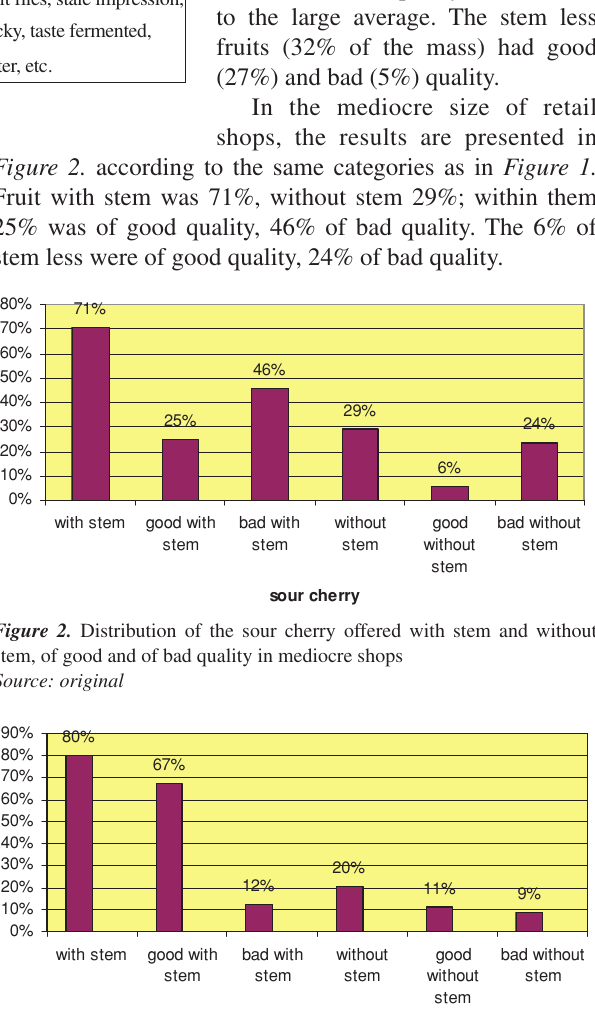
Figure 3. Distribution of the sour cherry offered with stem and without stem, of good and of bad quality in super-and